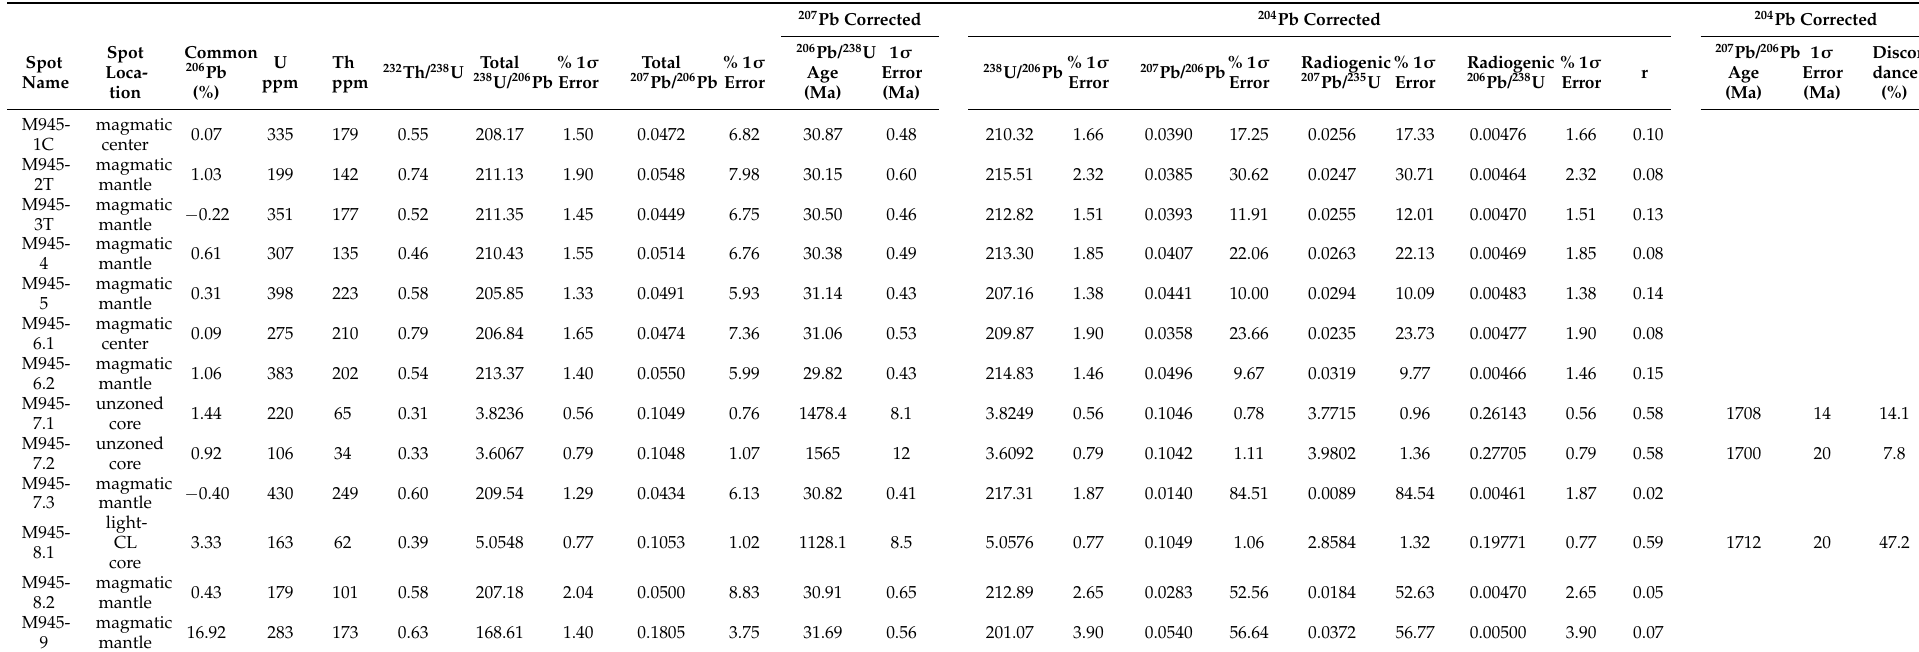
Table 3. SHRIMP-RG U/Pb data for zircon grains separated from M945-R, a sample of a rhyolitic quartz-porphyry dike at the upper Mineral Products mine, Alunite Ridge, Marysvale, Utah. Uncertainties for 206 Pb/ 238 U and 207 Pb/ 206 Pb ages are rounded to two significant figures, and the corresponding dates are rounded to the same decimal